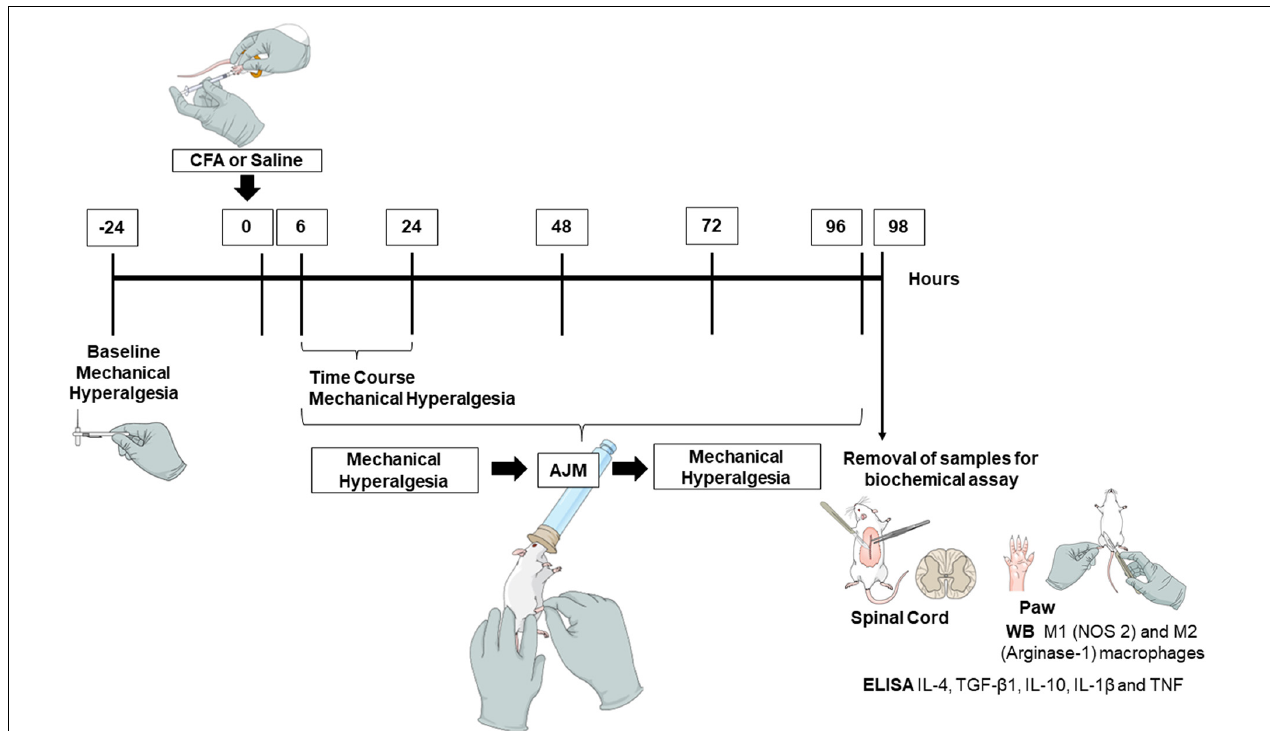
FIGURE 1 | Experimental design. To conduct this study, we performed baseline assessments to determine the parameters of mechanical hyperalgesia using the von Frey test. From this, we induced the inflammatory pain model by injection of CFA or saline (i.pl.), and performed the evaluations from 6, 24, 48, 72, and 96 h, pre- and post-treatments (AJM or Sham). Approximately 98 h after the injection of CFA and 2 h after the last treatment with AJM, mice were anesthetized and euthanized to remove the samples (spinal cord and paw) for biochemical assay. CFA, Complete Freund’s Adjuvant; AJM, Ankle Joint Mobilization; ELISA, Enzyme-Linked Immunosorbent Assay; TNF, Tumor Necrosis Factor; IL, Interleukin; WB, Western blotting; NOS 2, Nitric Oxide Synthase 2; TGF- β 1, Transforming Growth Factor- β